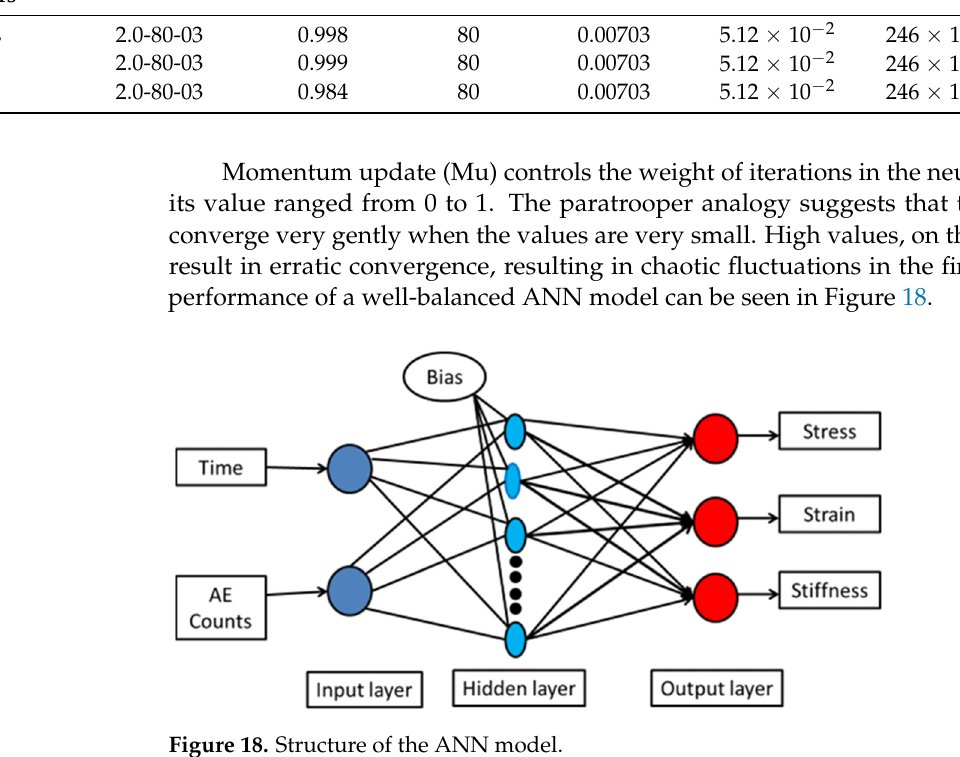
Figure 18. Structure of the ANN